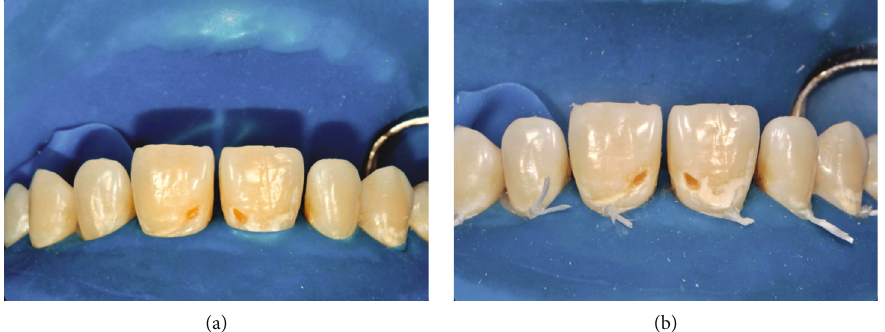
Figure 2: (a) Rubber dam isolation. (b) Addition of fl oss tie knots to ensure soft tissue retraction.